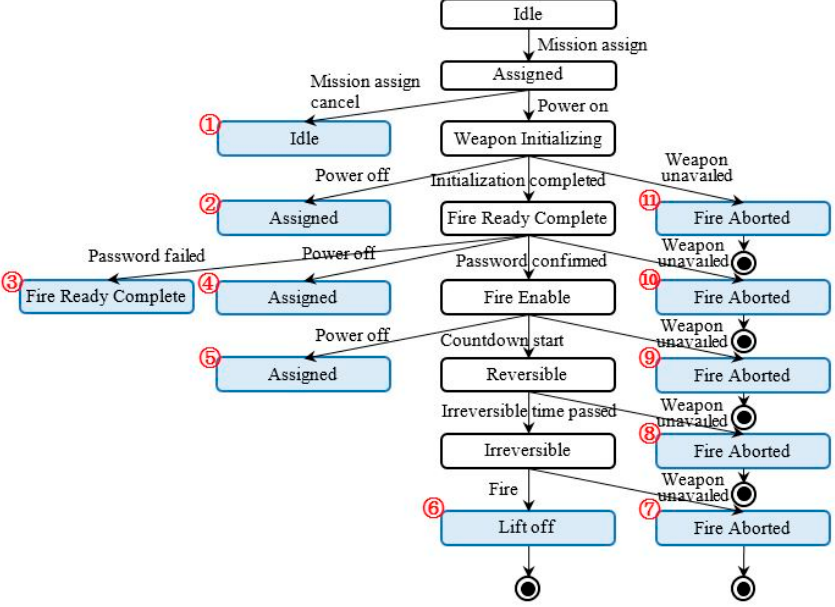
Figure 10. Tree derived using W method.